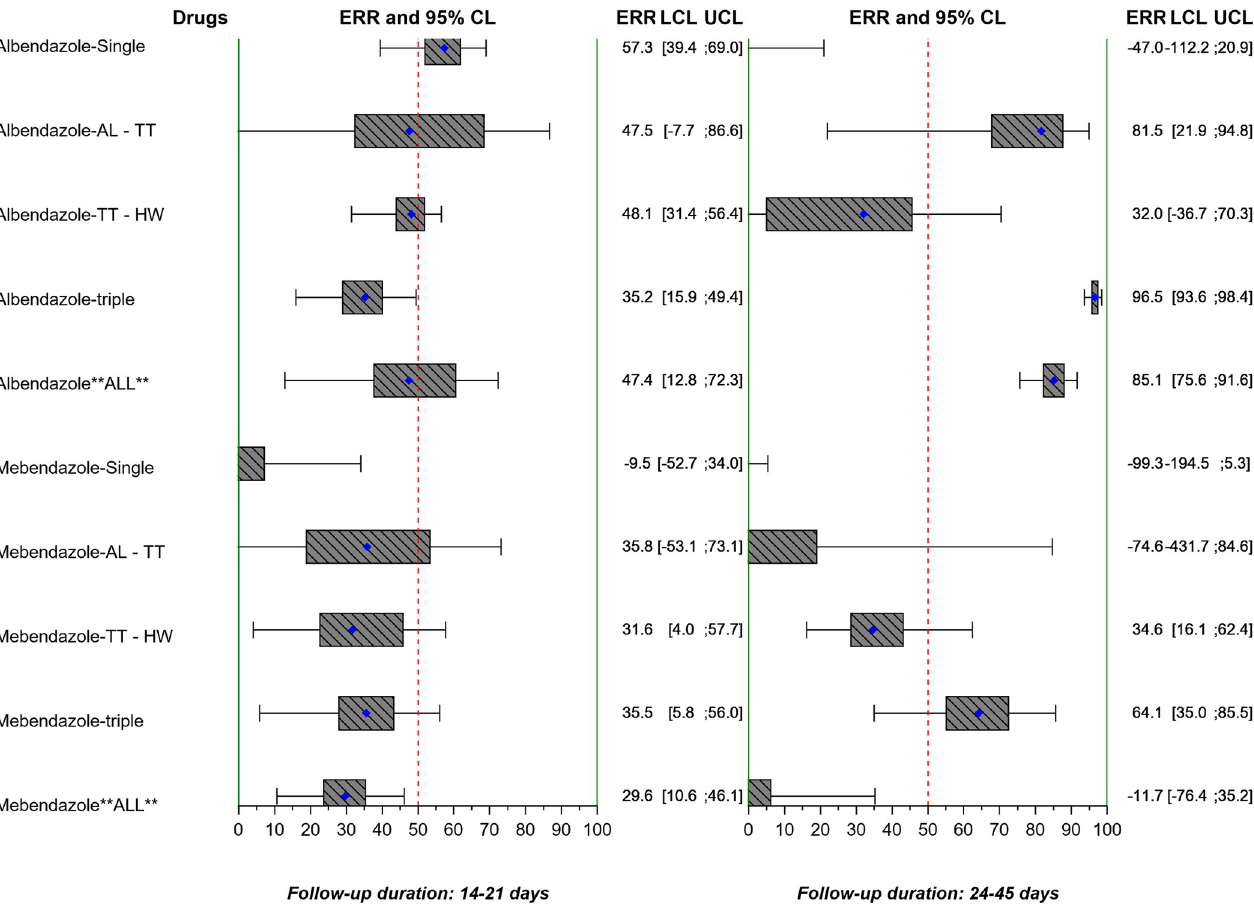
Fig 7. Forest plot of geometric mean ERR of hookworm by study. The vertical lines correspond to the WHO minimal criteria for efficacy [8] by species, as well as drug in the case of albendazole ( A . lumbricoides > 95%, T . trichiura > 50%, and hookworm > 90%), and mebendazole ( A . lumbricoides > 95%, T . trichiura > 50%, and hookworm > 70%). ERR: egg reduction rate; CL: confidence limits; LCL: lower confidence limit; UCL: upper confidence limit; AL: A . lumbricoides ; TT: T . trichiura ; HW: hookworm.